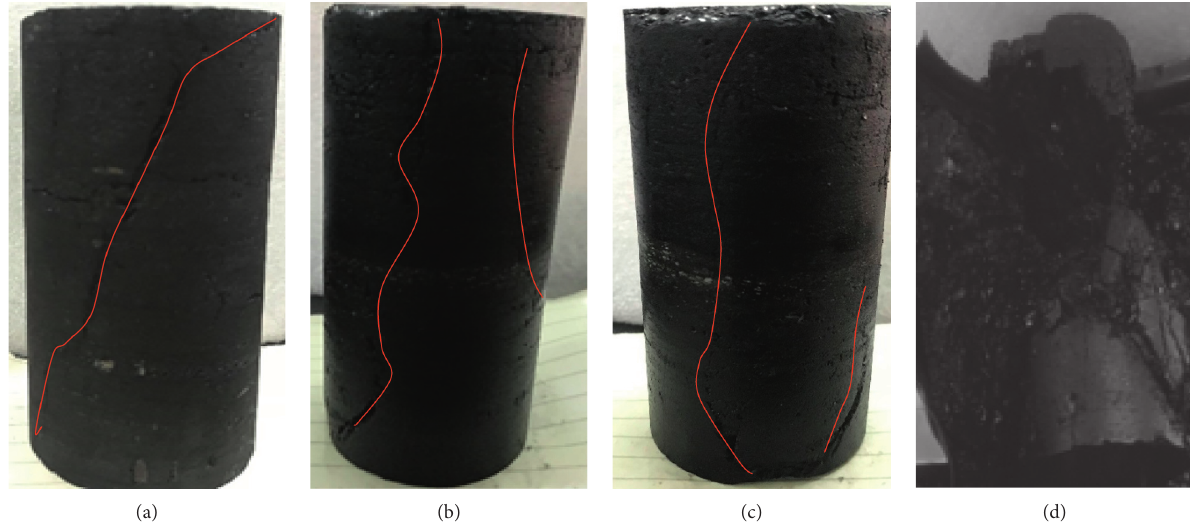
Figure 10: Destruction status of coal samples at different unloading rates. (a) No. 4 coal sample. (b) No. 5 coal sample. (c) No. 6 coal sample. (d) No. 7 coal